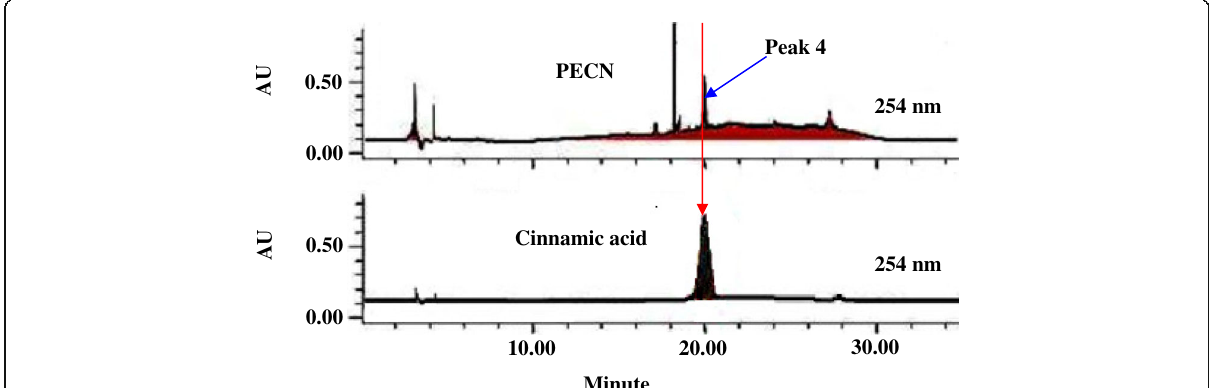
Fig. 7 Comparison of chromatogram between PECN and several phenolic compounds at the wavelength of 254 nm demonstrated one peak that was believed to represent (Peak 4) cinnamic acid. Only chromatogram of cinnamic acid was presented for comparison